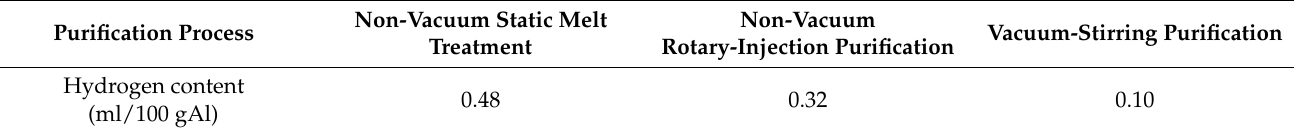
Table 3. Hydrogen content of Al-6Mg alloy sample under different melt purification conditions.